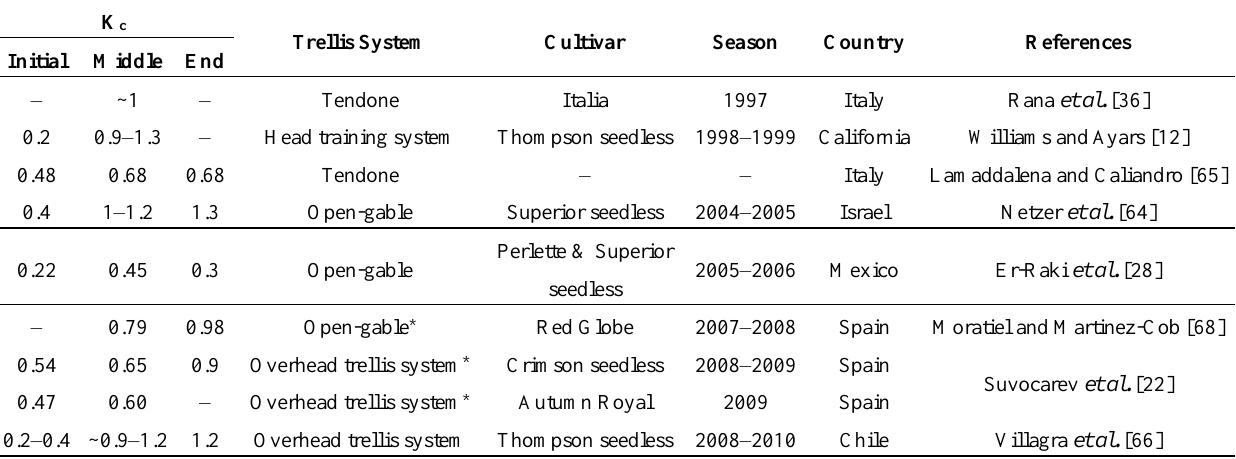
Table 5. K c values of table grapes reported in